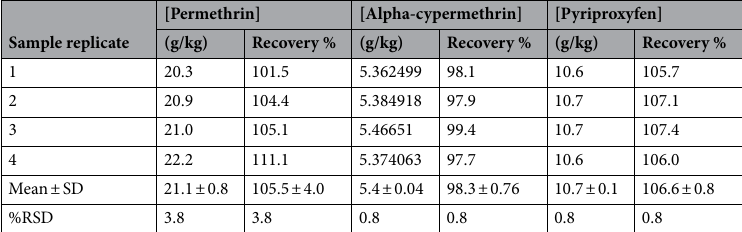
Table 3. Accuracy and precision test for blank net fortified with permethrin, alpha-cypermethrin and pyriproxyfen active ingredients. SD standard deviation and % RSD relative standard deviation (SD/Mean*100).